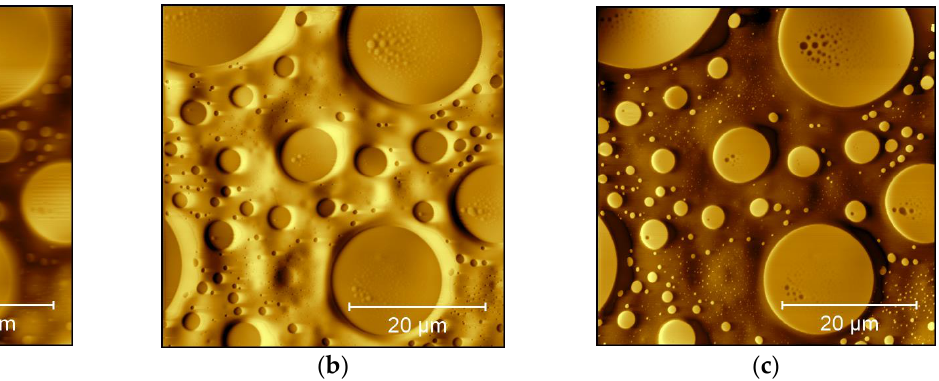
Figure 1. Atomic force microscopy (AFM) images of a polystyrene/styrene - butadiene - styrene block - copolymer (PS/SBS) blend: ( a ) topography (height range 1.4 µm); ( b ) amplitude; ( c ) phase image (phase range 137°).